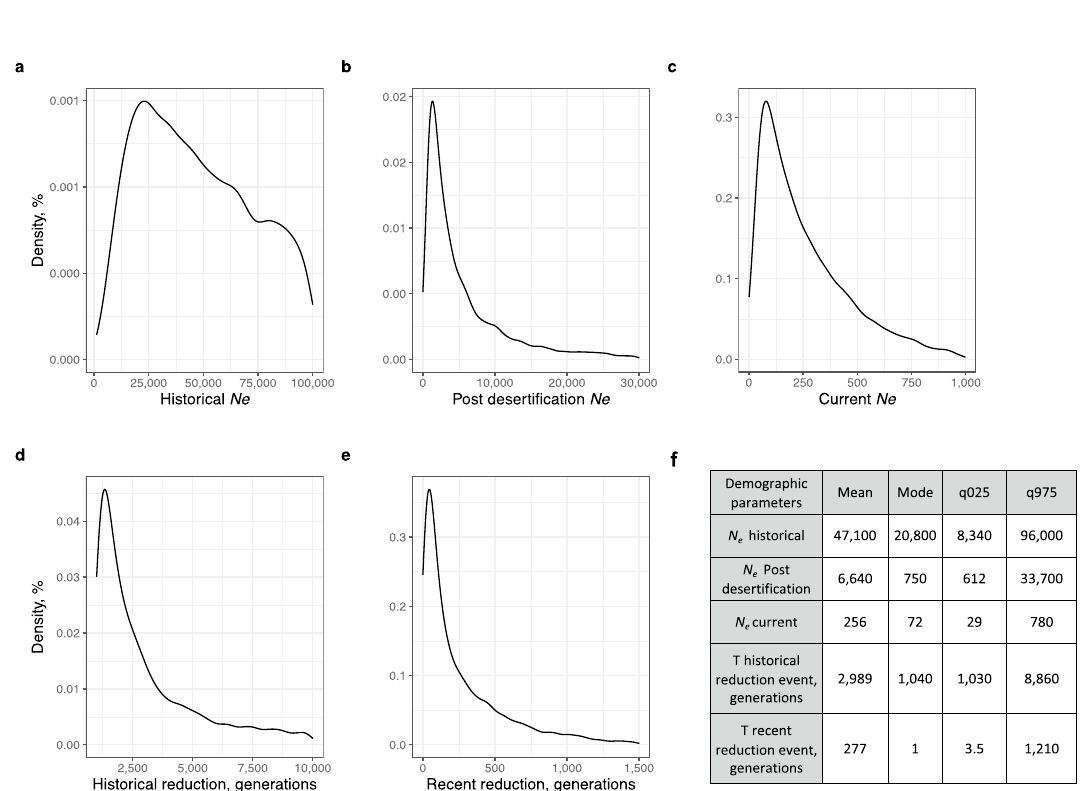
Figure 2. Posterior density curves and numerical estimates of demographic parameters for the best supported demographic scenario, which contains both a historical and a more recent reduction. ( a ) Historical effective population size; ( b ) effective population size before the recent demographic reduction; ( c ) current effective size of the captive peninsular pronghorn herd; ( d ) the number of generations since the historical